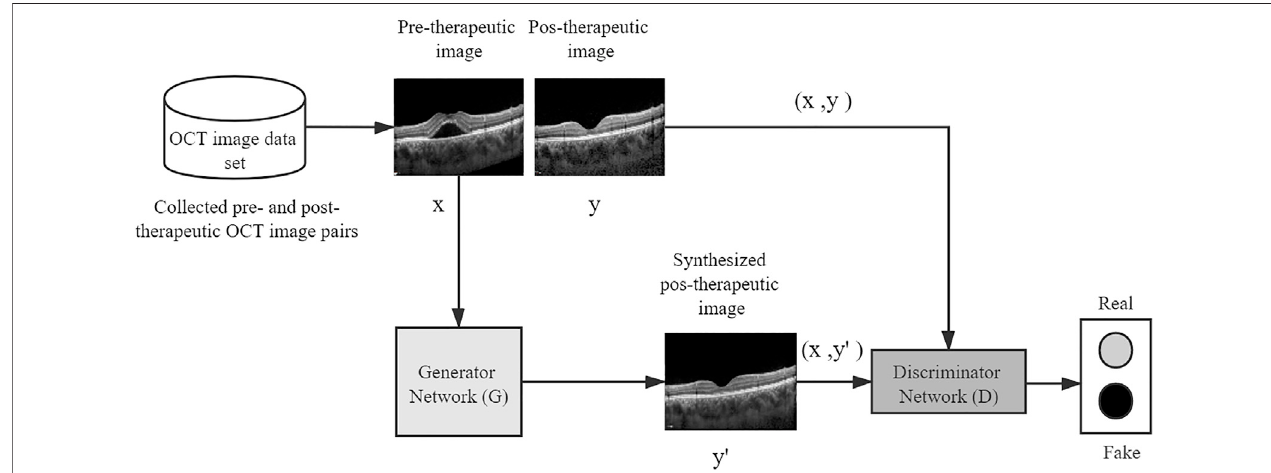
FIGURE 2 | A conceptual illustration of generating post-therapeutic OCT from pre-therapeutic OCT by the pix2pixHD. OCT, optical coherence tomography.